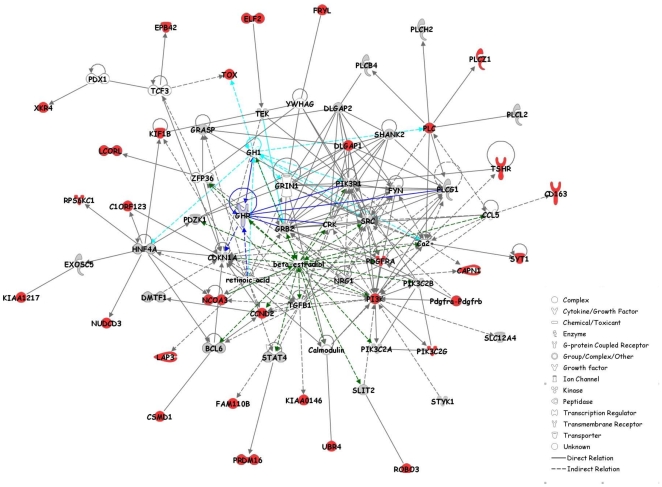
Representation of the gene network GN.Symbols corresponding to genes under selection are colored in red. Genes colored in grey were represented in our study but did not display any evidence of selection. Links between GH1, GHR and β-estradiol and other GN molecules are colored in light blue, blue and green respectively.